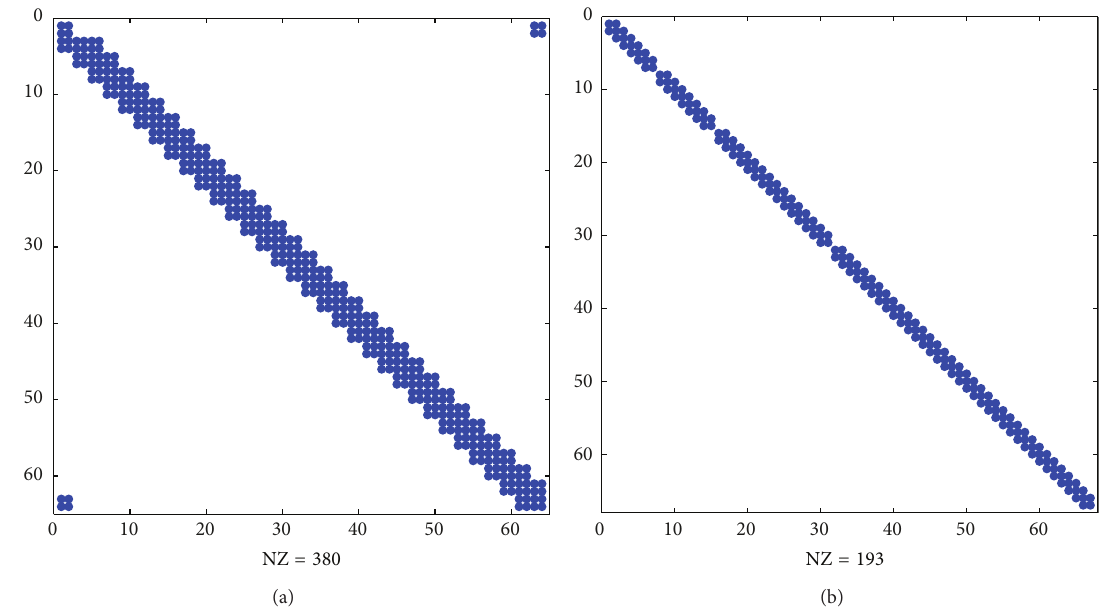
Figure 1: (a): Sparsity pattern of the periodized transform matrix 𝑇 of the cubic spline wavelet. transform matrix 𝑇 −1 cubic